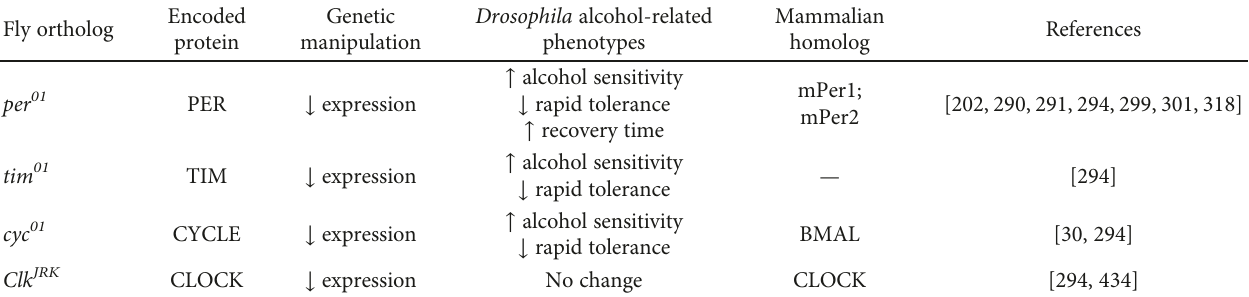
Table 2: Genes that mediate circadian and alcohol interactions.